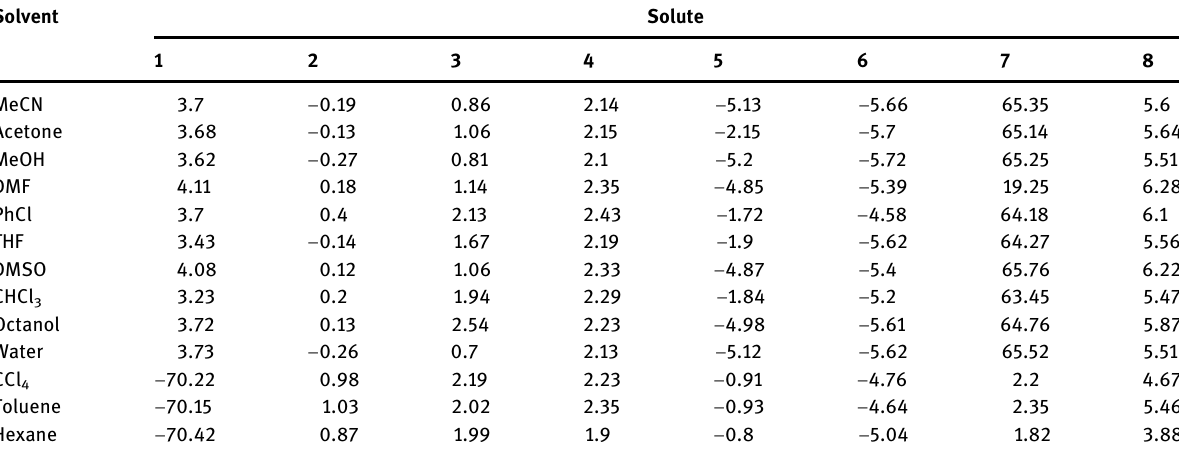
Table 10: Calculated di ff erences between values of λ max for azoles 1 – 8 at the B3LYP/6 - 311 ++ G ( 2d,3p ) //B3LYP/6 - 31G ( d,p ) level of theory in PCM solvation model and the gaseous phase ( Δ λ max [ nm ])